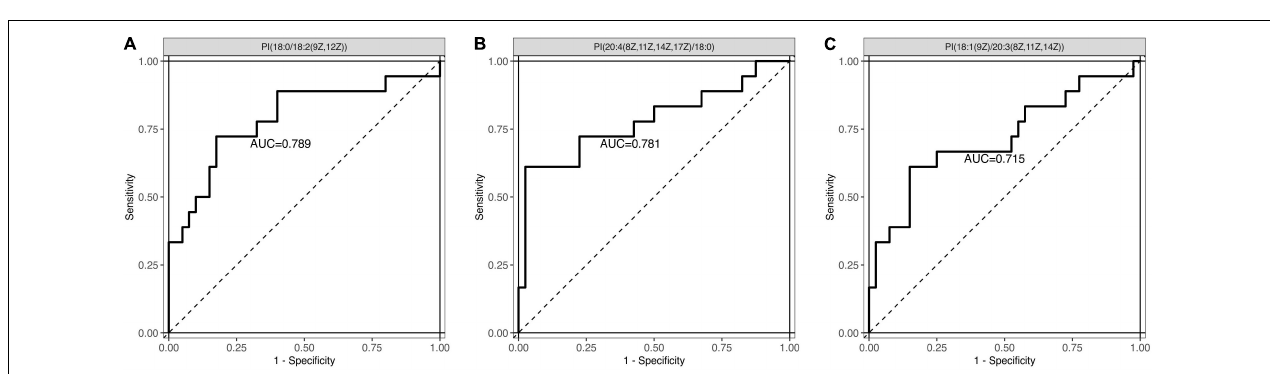
FIGURE 4 | Receiver operating characteristic (ROC) curve analysis was used to evaluated the specificity and sensitivity of these three potential biomarkers. (A) PI [18:0/18:2 (9Z, 12Z)]: the area under the curve (AUC) was 0.789. (B) PI [20:4 (8Z, 11Z, 14Z, 17Z)/18:0]: the AUC was 0.781. (C) PI [18:1 (9Z)/20:3 (8Z, 11Z, 14Z)]: the AUC was 0.715. PI,